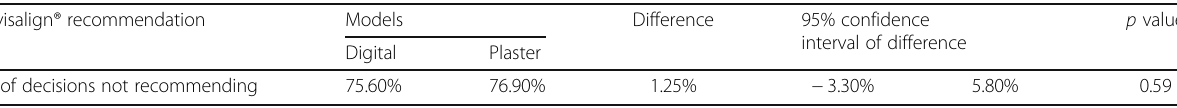
Table 3 Percentage of decisions aligners not recommended at T1 Invisalign®